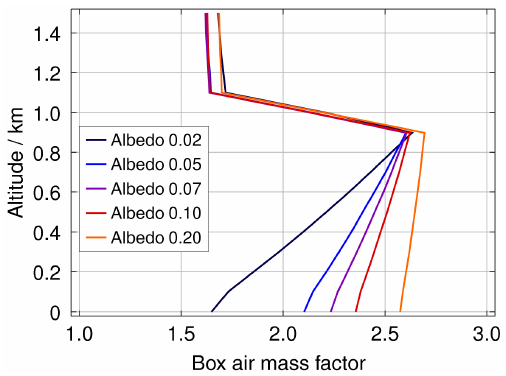
Figure 11. Air mass factors for NO 2 and their SZA dependence for different ground reflectance values for a NO 2 box profile of a mixed layer in the lowest